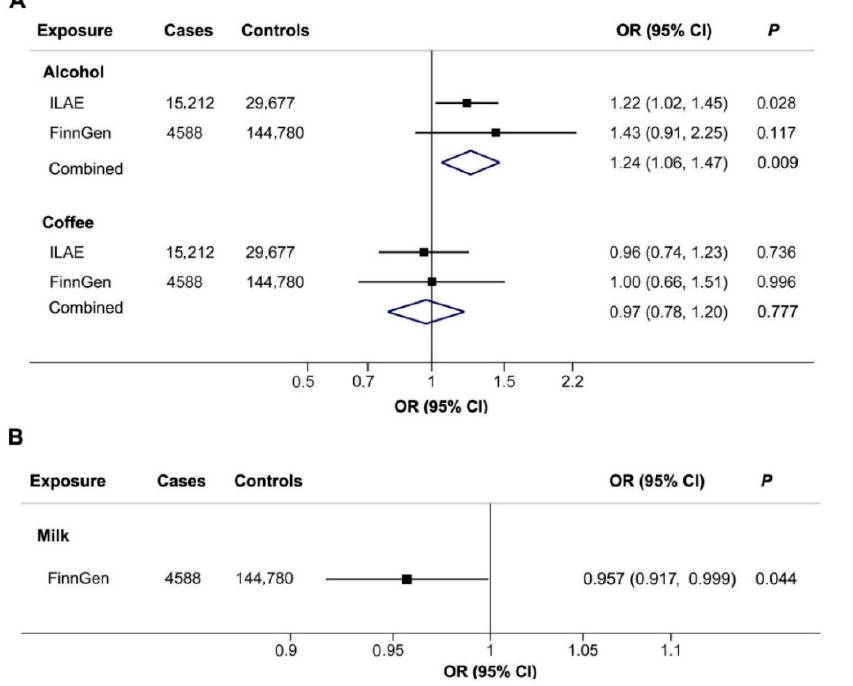
Figure 2. ( A ) Associations of genetically predicted alcohol and coffee intake with epilepsy in ILAE, in FinnGen, and combined analyses of both samples. ( B ) Association of genetically predicted milk intake with epilepsy in FinnGen.